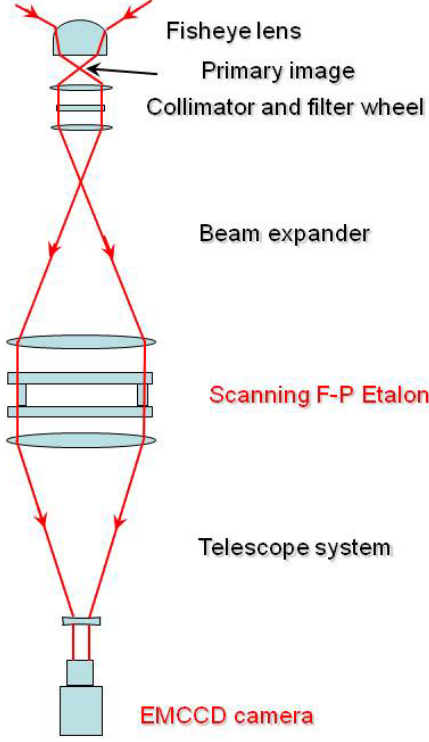
Fig. 2a. The Scanning Doppler Imager. Simplified optics (not-to- scale).